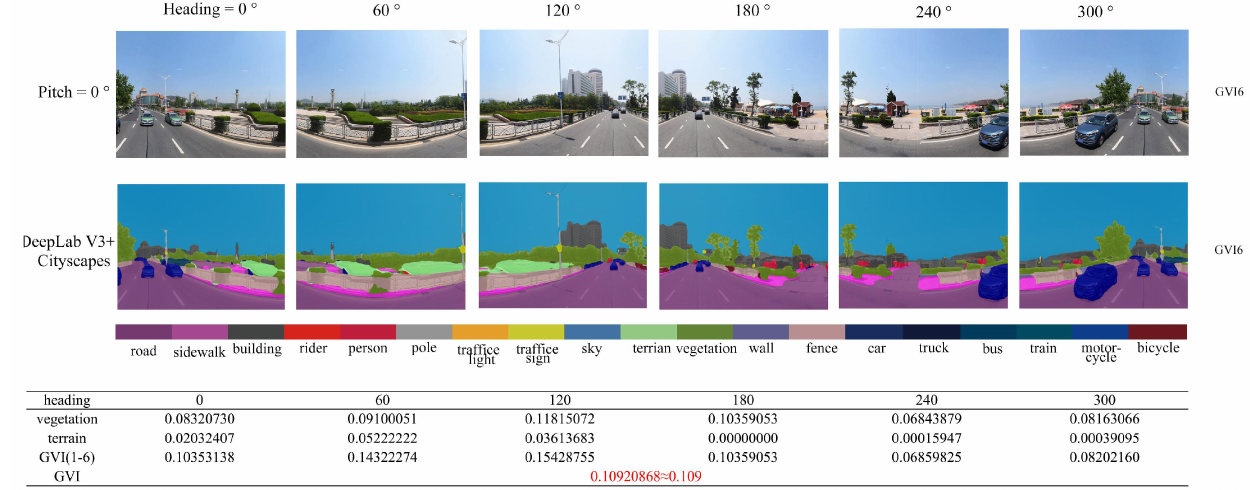
Figure 4. The semantic pixel-wise labeling of landscape